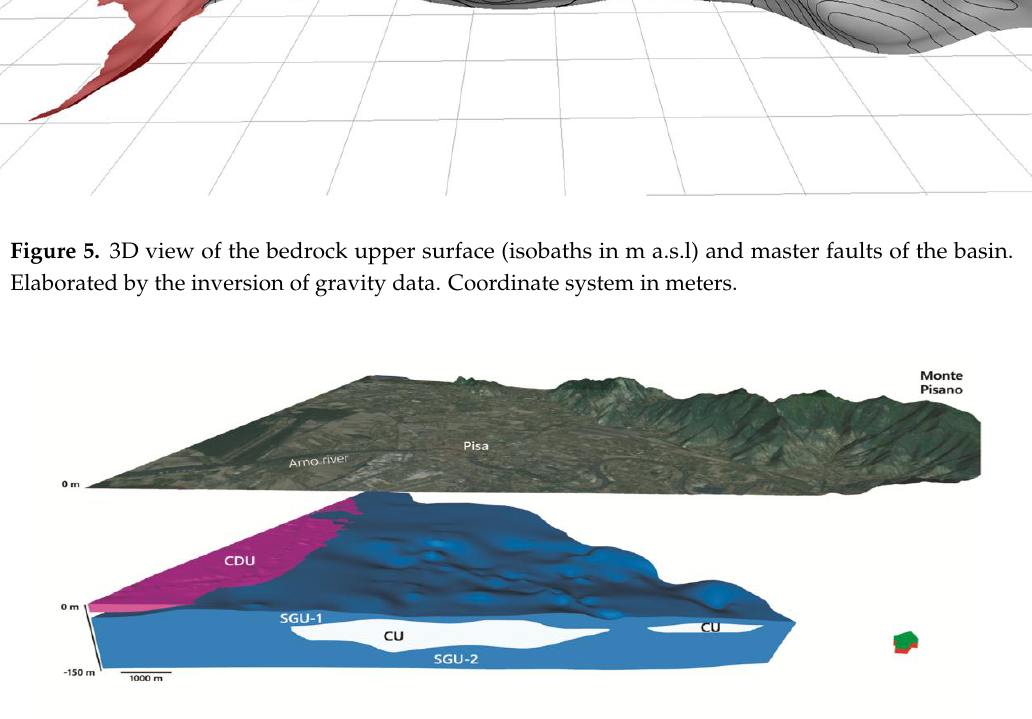
Figure 6. Section of the 3D model of the selected area. Underground vertical exaggeration: 10×. Topographic surface vertical exaggeration: 2×.